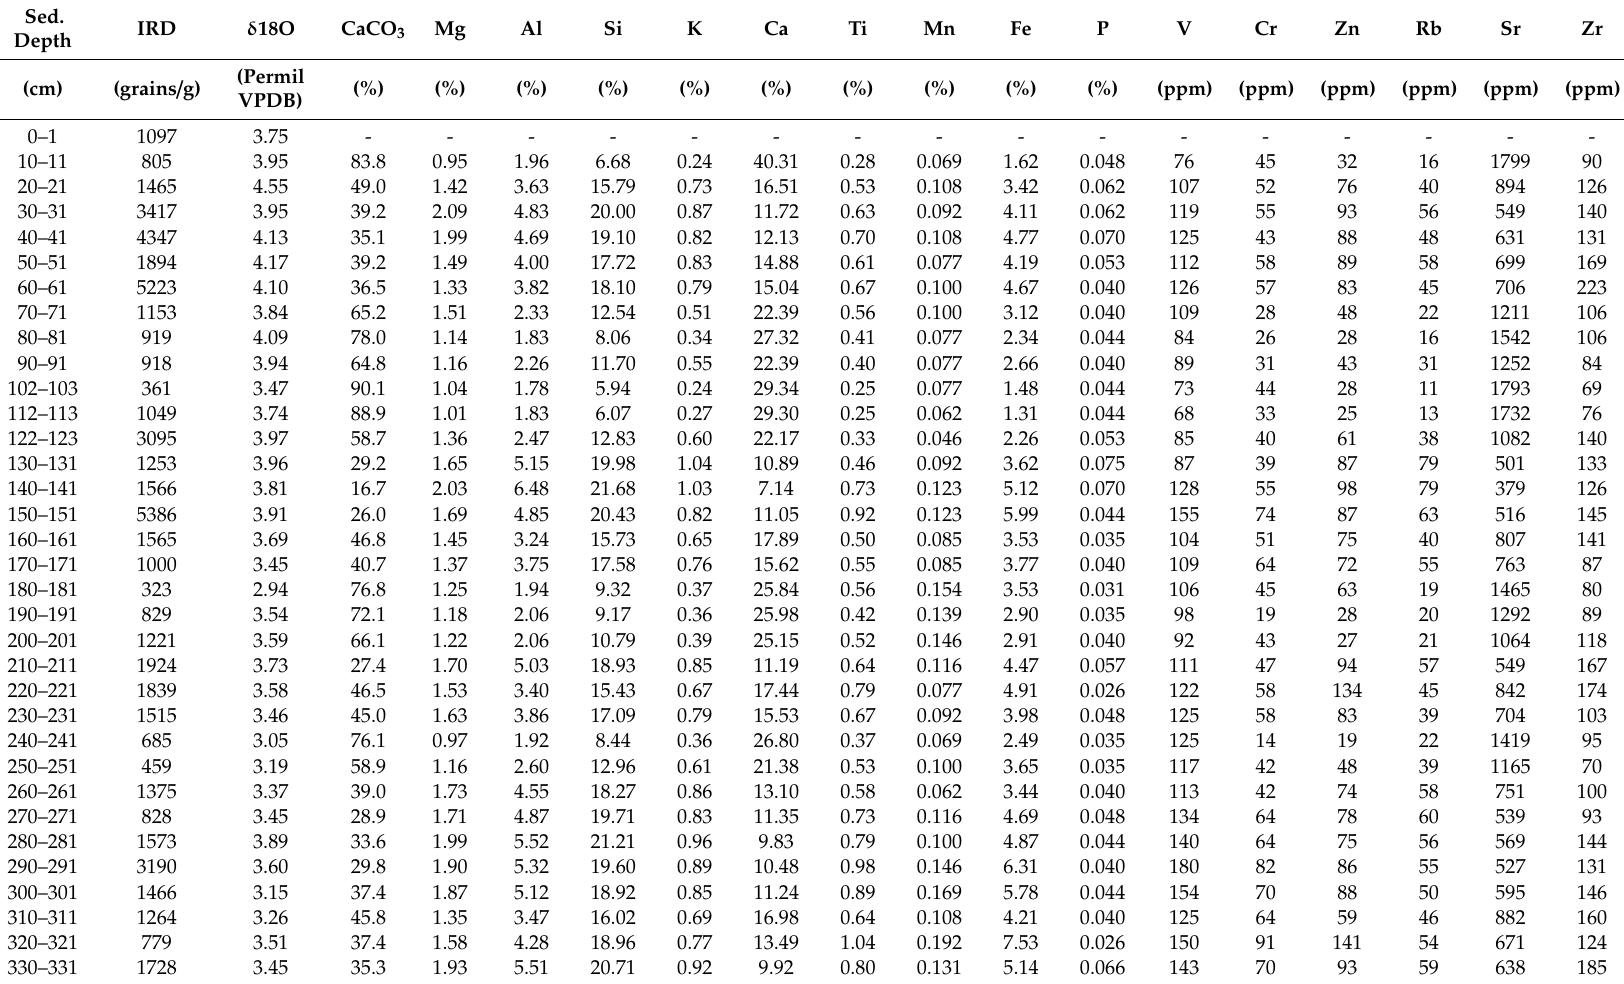
Table 1. Counts of IRD, δ 18 O, contents of CaCO 3 , major and trace elements in sediment core AI-3378, the Snorri Drift